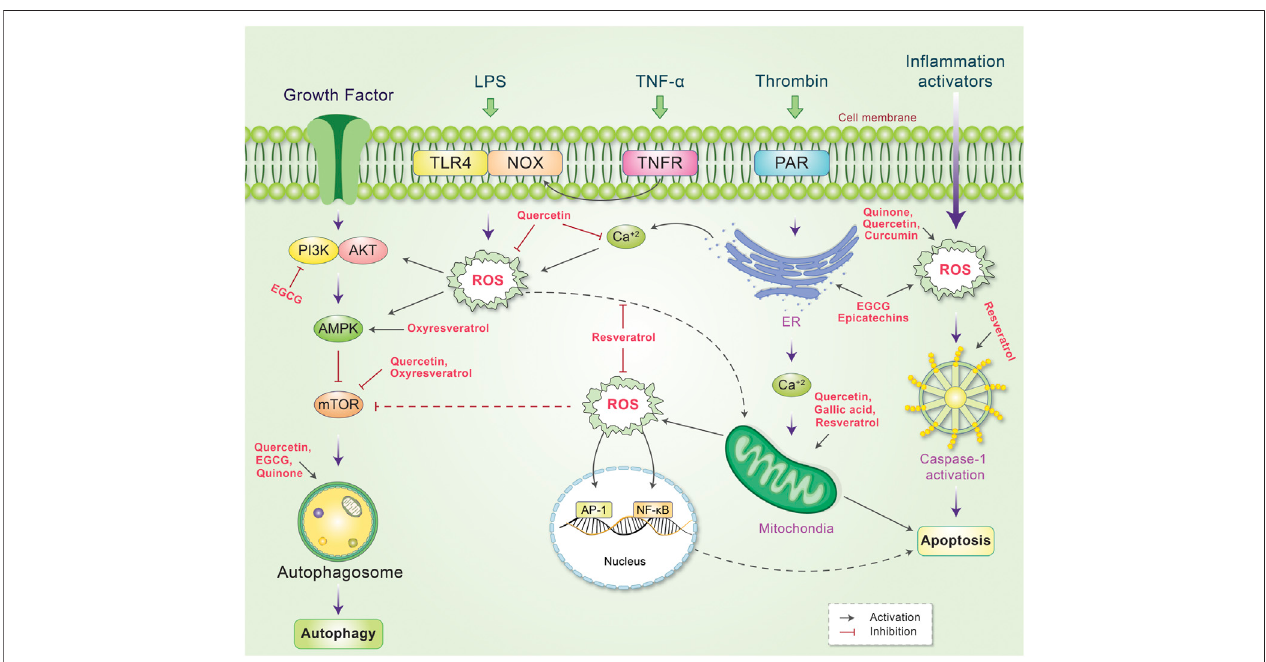
FIGURE 6 | Schematic representation of the mechanism of action of phytochemicals and reactive oxygen species (ROS), which lead to the control of several signaling pathways. ROS is produced by several internal and external stimuli. Extranally, ROS is activated through growth factors, LPS, TNF- α , thrombin, and in fl ammation. Different phytochemicals have been found to scavenge or decrease cellular ROS level by inhibiting or stimulating their action. Internally, phytochemicals inhibit PI3K or mTOR, which activates autophagy and reduces ROS production. Some phytochemicals have also been found to activate mitochrondrial ROS production while other phytochemicals scavenge ROS and protect against DNA damage. ROS production mediated by ER and in fl ammation activators is also reduced by phytochemicals, which modulate the autophagy-apoptosis pathways.